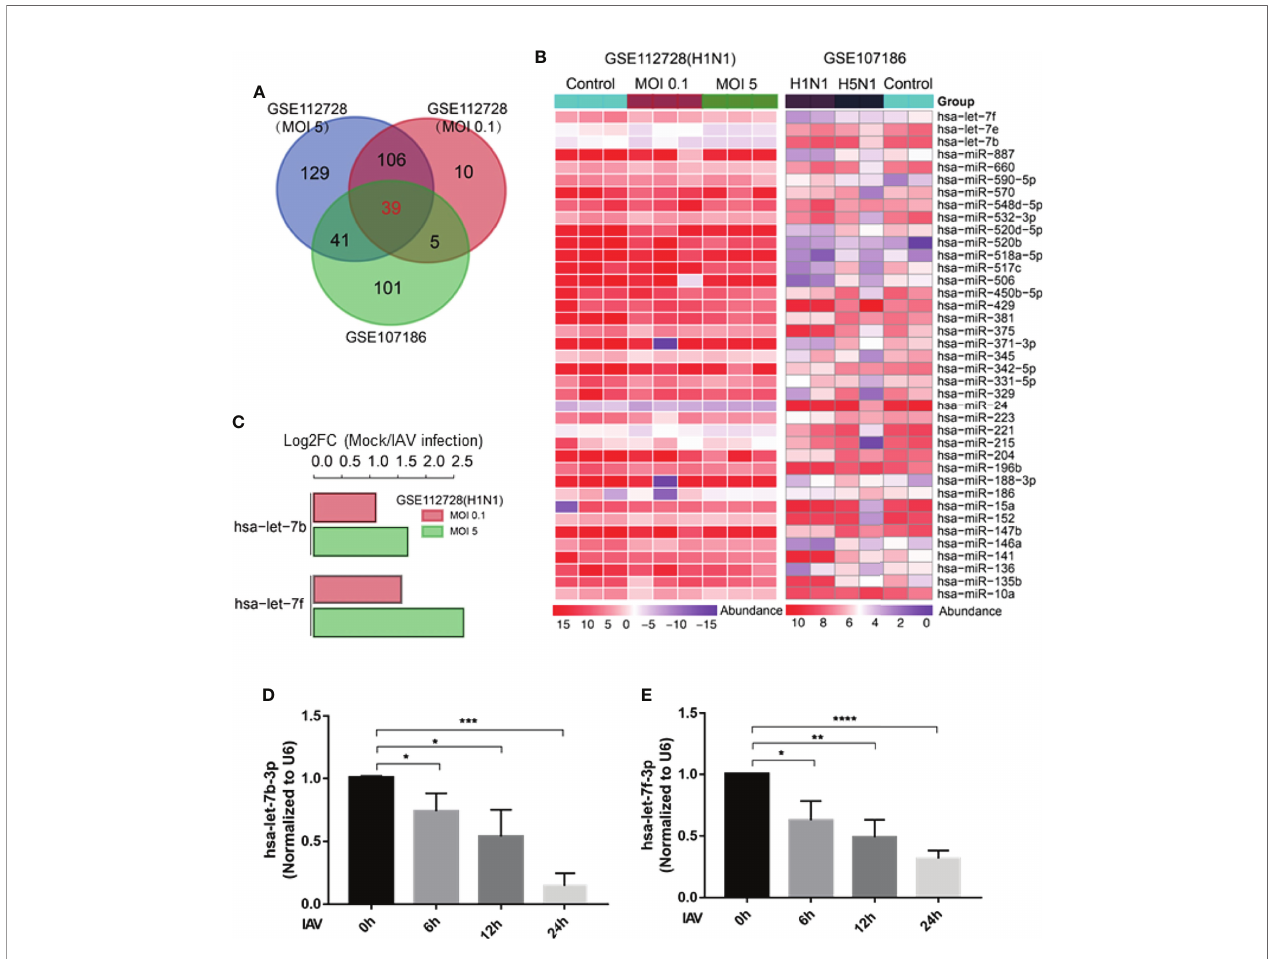
FIGURE 1 | Let-7 expression decreases after IAV infection. (A) Venn diagram of differentially expressed miRNAs during IAV infection. (B) Heat map representing the 39 downregulated miRNAs from the two microarray dataset GSE112728 and GSE107186. (C) Analysis of hsa-let-7b and hsa-let-7f down-regulation of in GSE112728 microarray that the cell infected with 0.1 and 5 MOI of IAV compared with Mock cell. (D, E) A549 cell was infected with in fl uenza A/WSN/1933 virus (MOI = 1) for 0, 6, 12 and 24h, the expression of hsa-let-7b-3p and hsa-let-7f-3p was accessed by real-time qPCR and normalized to expression of U6. Data are the mean ± SD from three independent experiments, * p < 0.05, ** p < 0.01 vs. 0h control cell by t